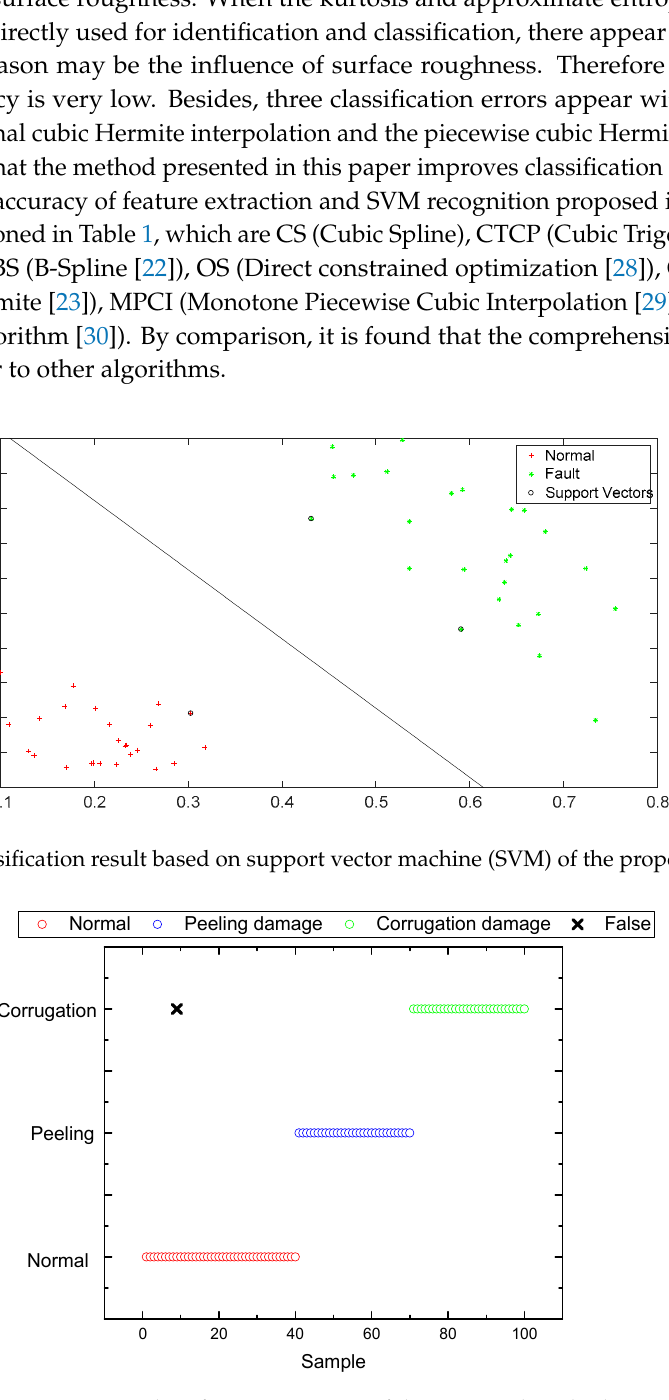
( b ) Figure 15. Analysis of a rail vibration signal with corrugation damage. ( a ) Waveform; ( b ) frequency spectrum. •